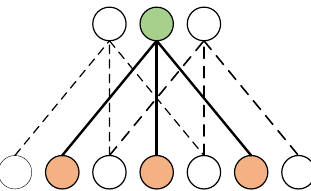
Figure 7. Dilated convolution. Dilation factors = 2, kernel size = 3.